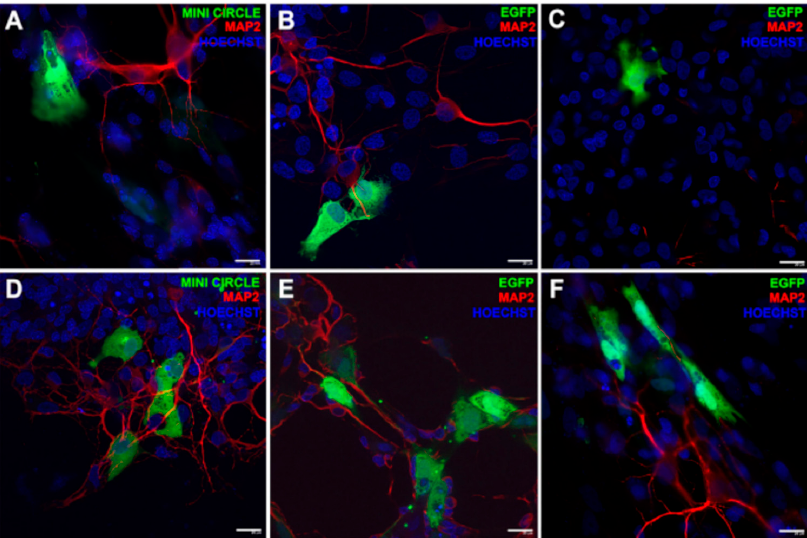
Figure 5. Fluorescence immonostaining by GFP expression in embrionary rat retinal primary cells. The green signal was referred to the transfection event of DST20 nioplexes with MC-GFP, ( B )